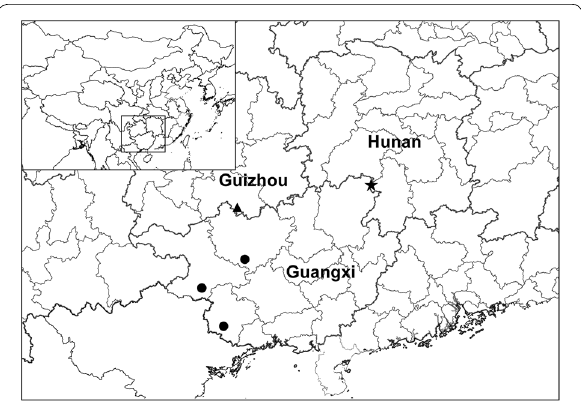
Fig. 8 Distribution of Paraboea dushanensis W.B.Xu & M.Q.Han (trian‑ gle), Paraboea sinovietnamica W.B.Xu & J.Guo (circle), and Paraboea xiangguiensis W.B.Xu & B.Pan (star) in